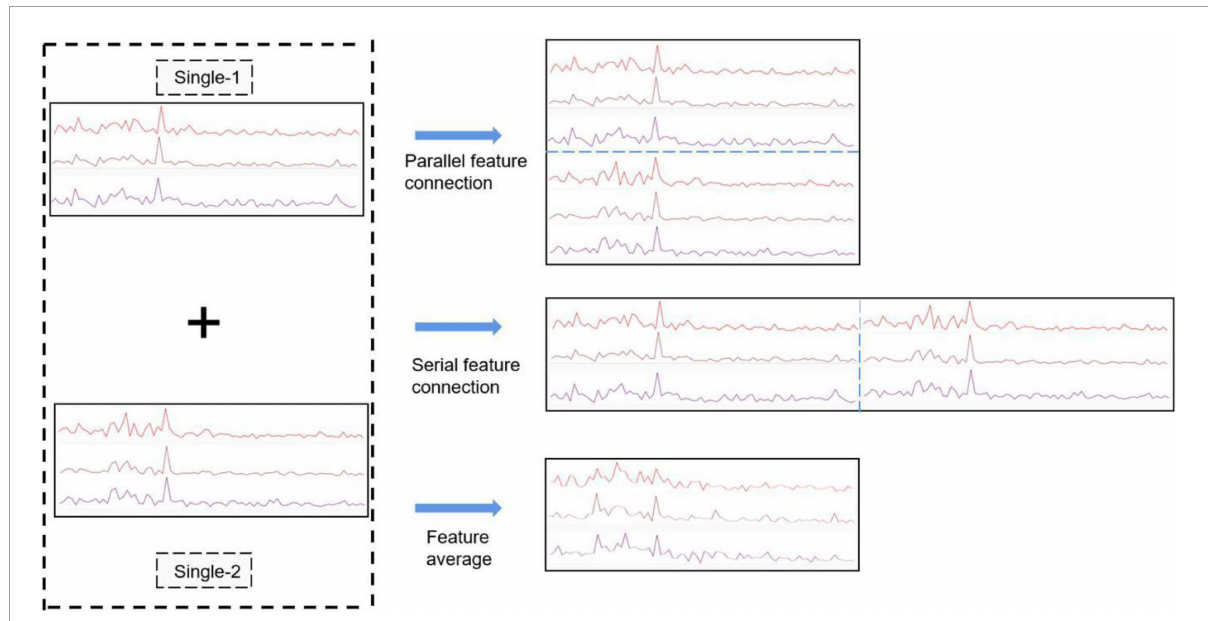
FIGURE3 Three fusion methods: (1) feature parallel connection (2) feature serial connection (3) feature averaging. Single-1 and Single-2 represent two single-person features for feature fusion.